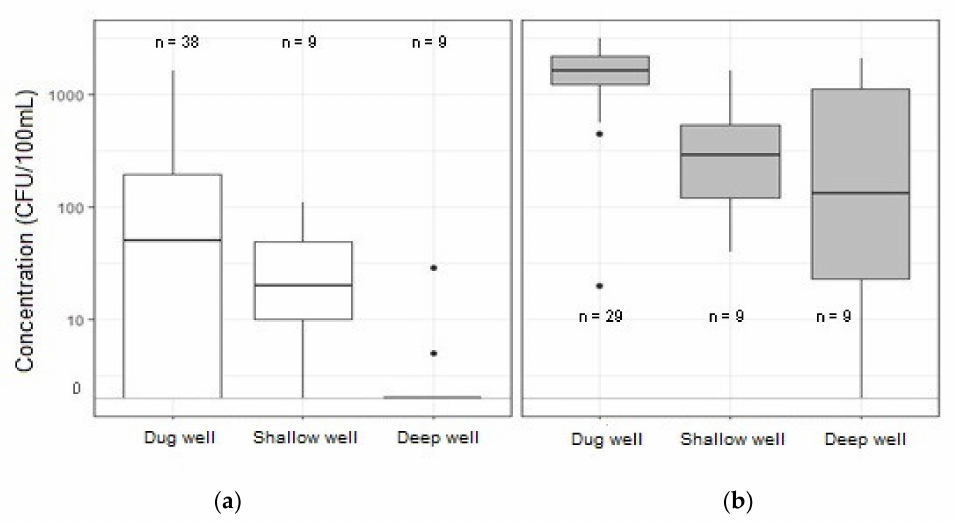
Figure 8. Distribution of ( a ) E. coli and ( b ) TC concentration in different well